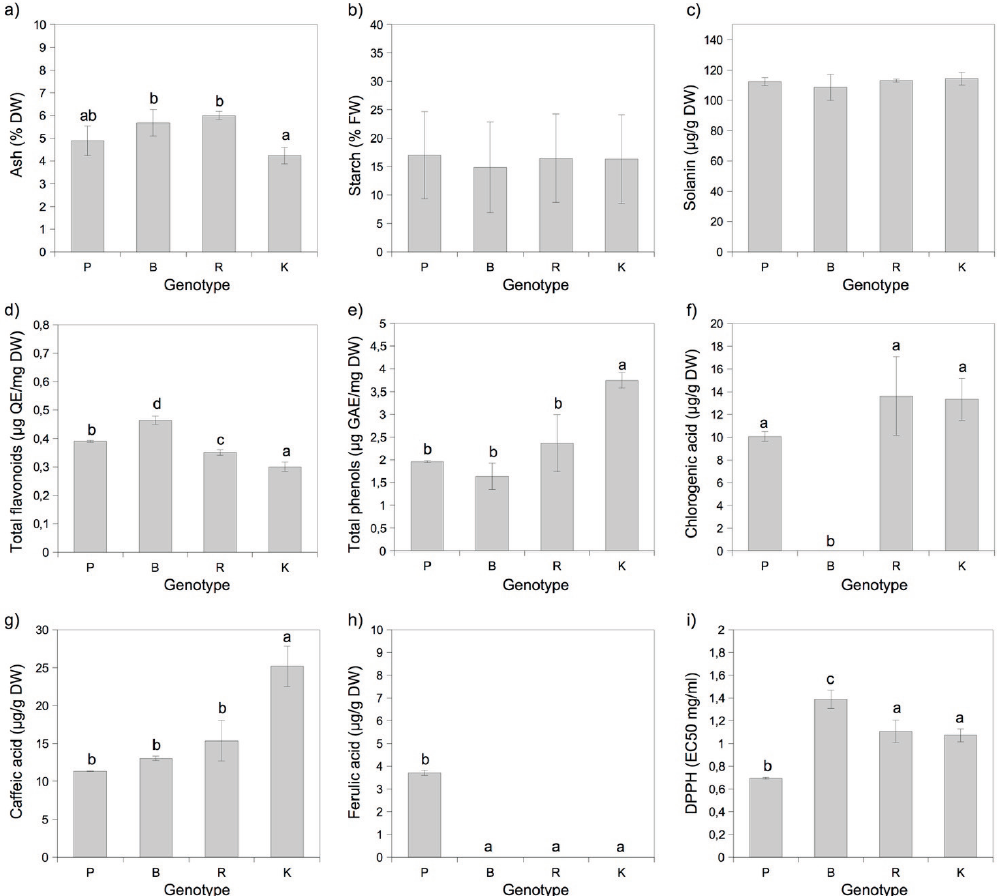
Fig. 4: Phytochemical features of the tubers of the four potato genotypes (P, Prugnona; B, Bianca; R, Rubra Spes; K, Kennebec): ash (a), starch content (b), solanine (c), total flavonoids (d), total phenols (e), chlorogenic acid (f), caffeic acid (g), ferulic acid (h), antioxidant activity (DPPH) (i). Different letters above the error bars indicate significant differences ( P < 0.05) among genotypes according to the Tukey post-hoc